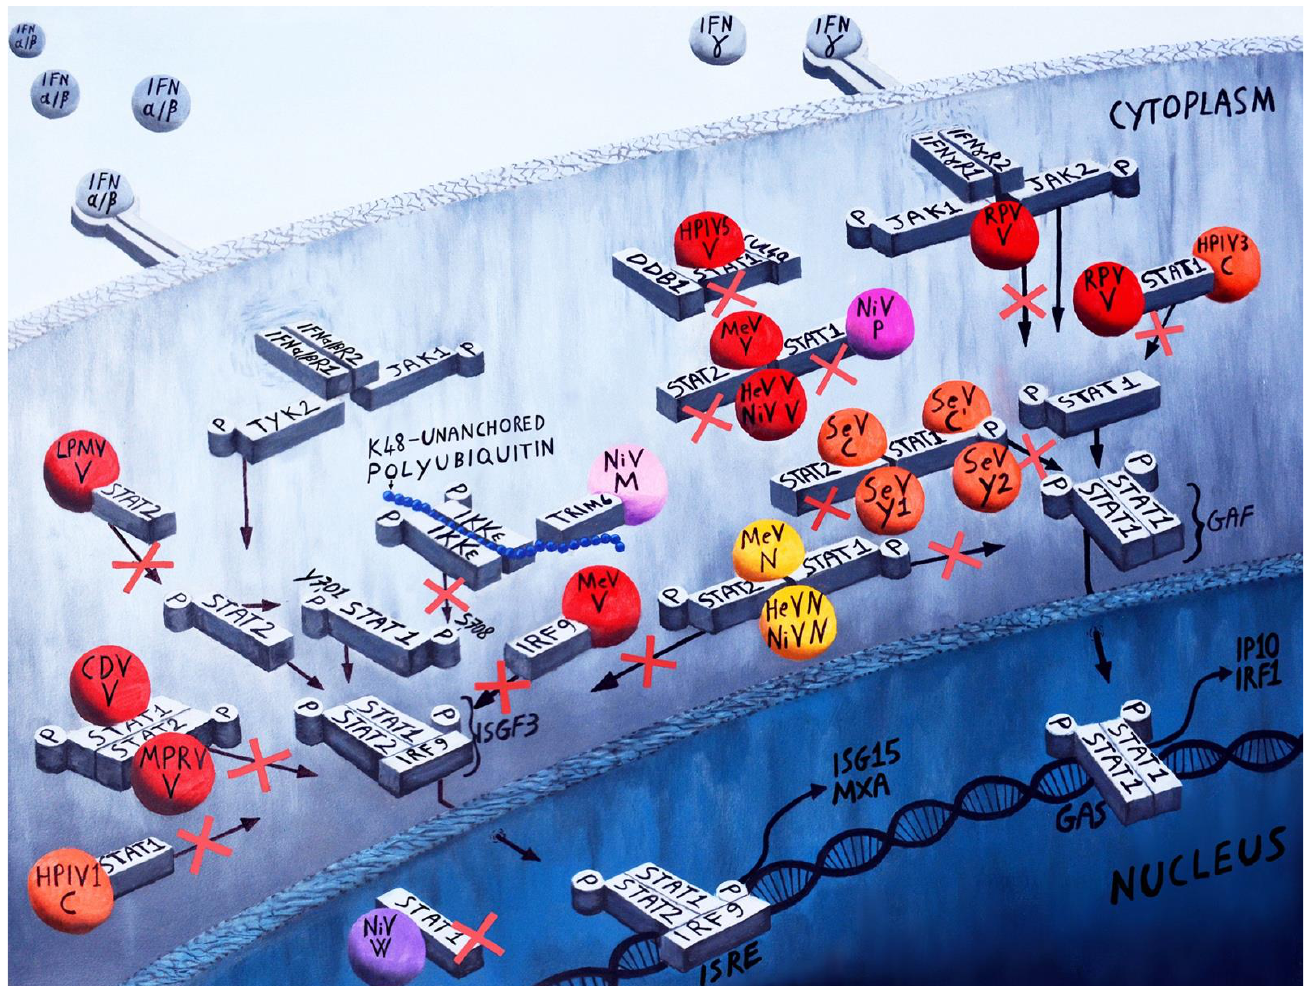
Figure 3. Antagonism of type I and type II IFN signaling pathways by Paramyxoviridae . Once interferon is produced, it will be released by the cells and will bind in a paracrine and autocrine manner to the interferon membrane receptors (IFNAR1 and IFNAR2). The binding with interferon receptors leads to the phosphorylation of JAK1 and TYK2. Subsequently, the activated Janus kinases activate and phosphorylate STAT2 and STAT1. Phosphorylated STAT1 and STAT2 dimerize and bind to interferon regulatory factor 9 (IRF9) to form a complex STAT1-STAT2-IRF9 called IFN-stimulated gene factor 3 (ISGF3). The ISGF3 translocates to the nucleus and binds to the DNA sequences called: IFN-stimulated response elements (ISREs) within a group of genes known as interferon-stimulated genes (ISG). This binding activates the transcriptions of more than 100 ISGs. All these genes establish an antiviral state that limits viral replication and dissemination. Type II IFN (IFN- γ) is produced by activated immune cells and leads to the production of a different subset of ISGs via a distinct signaling pathway. Type II IFN (IFN ) binds to a different receptor complex also formed of two subunits: IFN- γR1 and IFN - γR2 . Type II IFN signaling activates STAT1 by phosphorylation, which homodimerizes to form the interferon gamma factor (GAF), which translocates to the nucleus and binds to DNA at γ -activated sequence (GAS) elements within a different group of ISGs. Most of the paramyxoviruses are able to neutralize the type I and type II IFN signaling pathways by targeting most of the transcription factors involved. Most of V proteins from paramyxovirus are represented in red, interacting with type I and type II IFN signaling pathways transcription factors represented in light gray. LPMV V: La Piedad Michoacán Mexico Virus V protein, MPRV V: Mapuera virus V protein, MuV V: Mumps virus V protein, PIV5 V: Parainfluenza virus 5 V protein, MeV V: Measles virus V protein, CDV V: Canine distemper virus V protein, HeV V: Hendra virus V protein, NiV V: Nipah virus V protein, SeV V: Sendai virus V protein. Most C proteins from paramyxovirus are represented in orange, interacting with type I and type II IFN signaling transcription factors represented in light gray. NiV C: Nipah virus C protein, SeV C: Sendai virus C protein, SeV C`: Sendai virus C` protein, SeV Y1: Sendai virus Y1 protein, SeV Y2: Sendai virus Y2 protein,